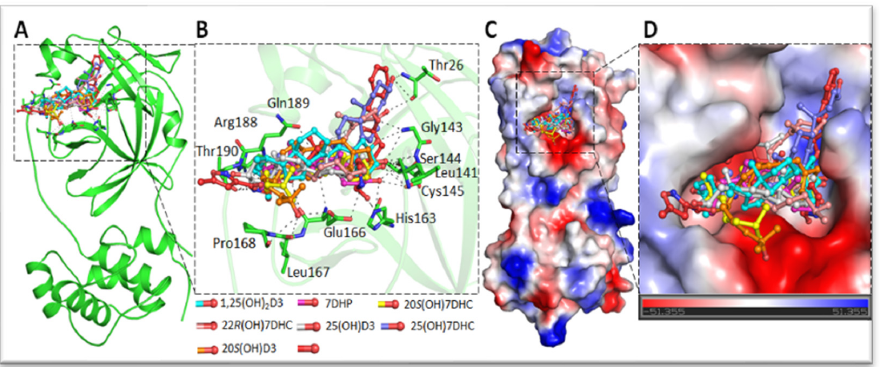
show anti-viral activity [104].